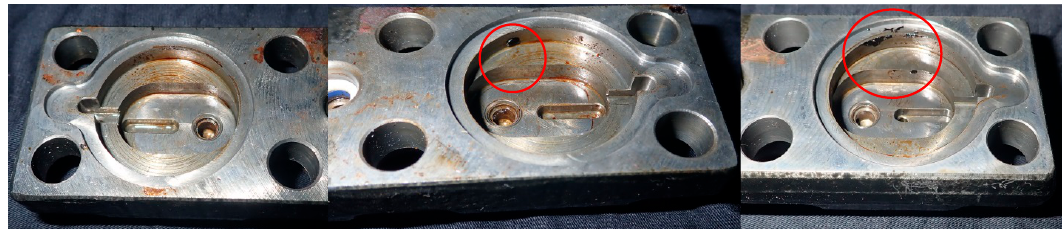
Figure 15. Top view of pumping elements covered by gummy deposits.